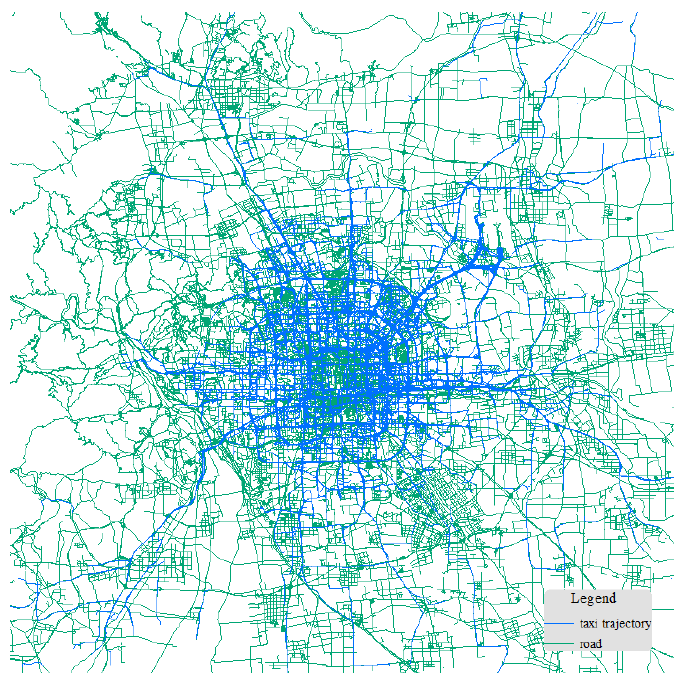
Figure 3. Reconstructed structure of the road network in Beijing from taxi trajectories.